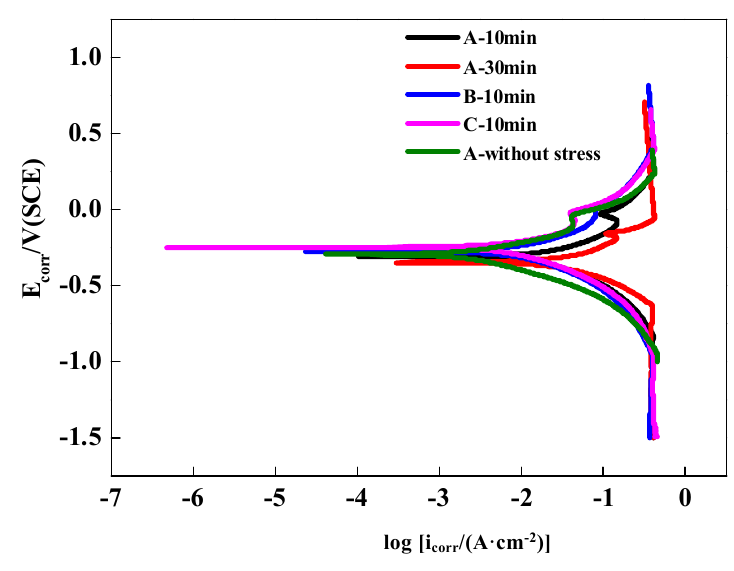
Figure 2. Potentiodynamic polarization curves of steel wires in NH 4 SCN solution.